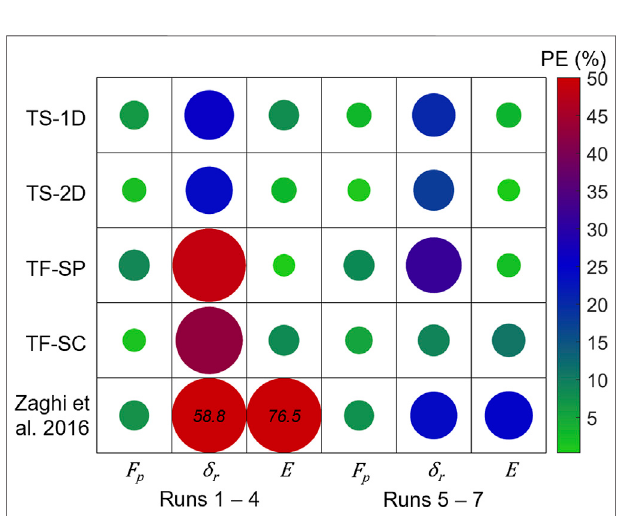
FIGURE 11 | Performance of the CNN-predicted model parameters in capturingtheengineeringmetricswhenprompted withtheexperimental data. The size and color of the circles are proportional to the error